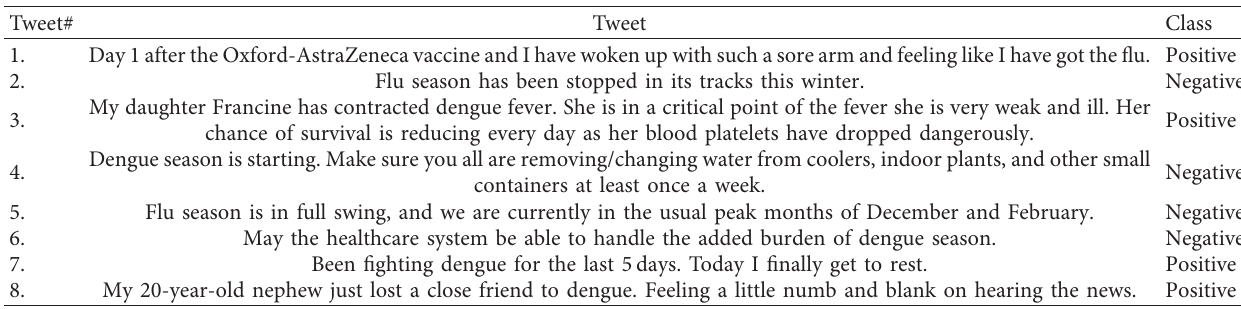
Table 2: Sample tweets related to the dataset for a training set.